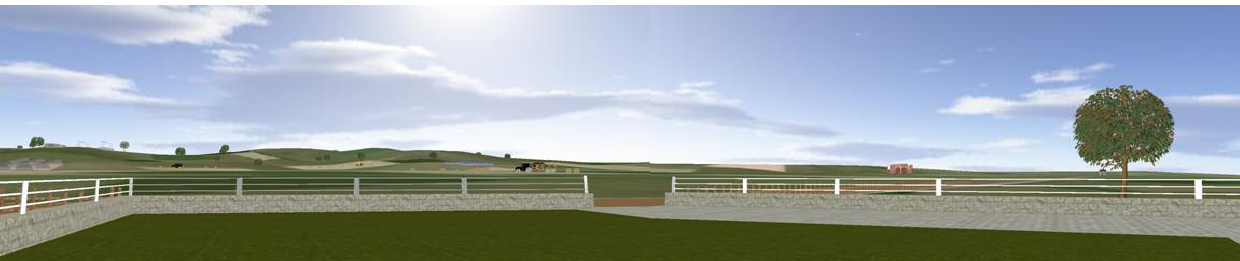
Figure 1. The virtual scenario without wind